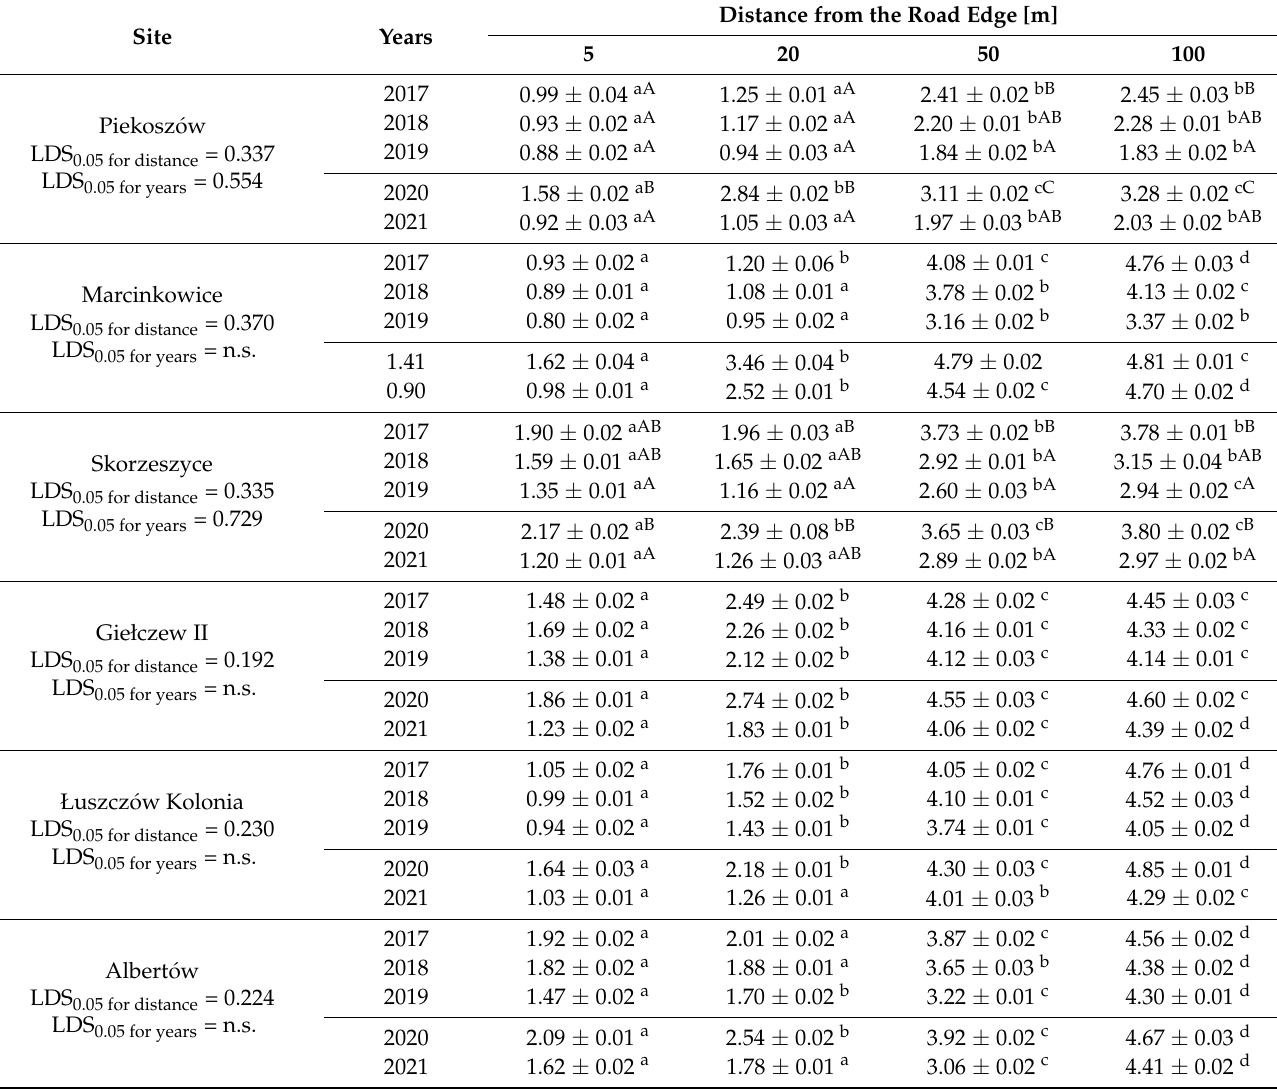
Explanation: a–d —different letters indicate significant difference at p ≤ 0.05 (LDS for distance from the road edge); A–C —different letters indicate significant difference at p ≤ 0.05 (LDS for years 2017–2021); n.s.—not significant at p ≤